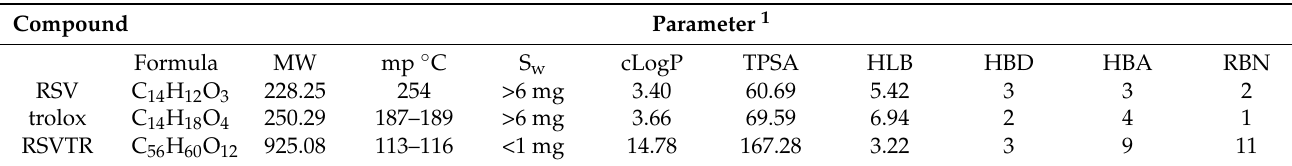
Table 1. Physicochemical properties and molecular descriptors of resveratrol (RSV), trolox, and resveratrol triester with trolox (RSVTR).